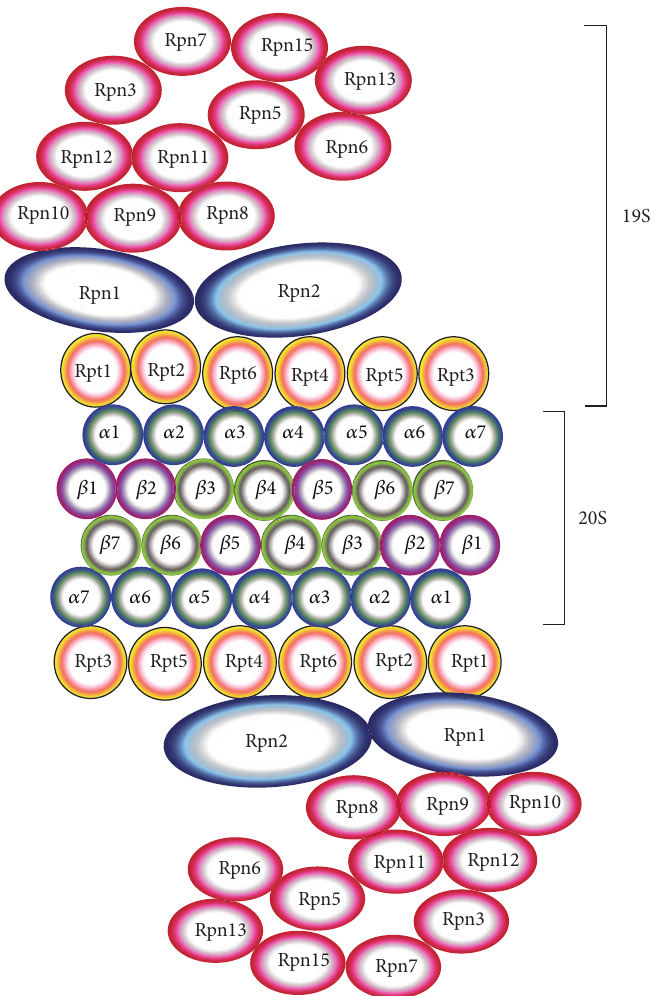
Figure 2: Schematic diagram of the 26S proteasome. The 26S proteasome is composed of the core 20S proteasome and the 19S proteasome